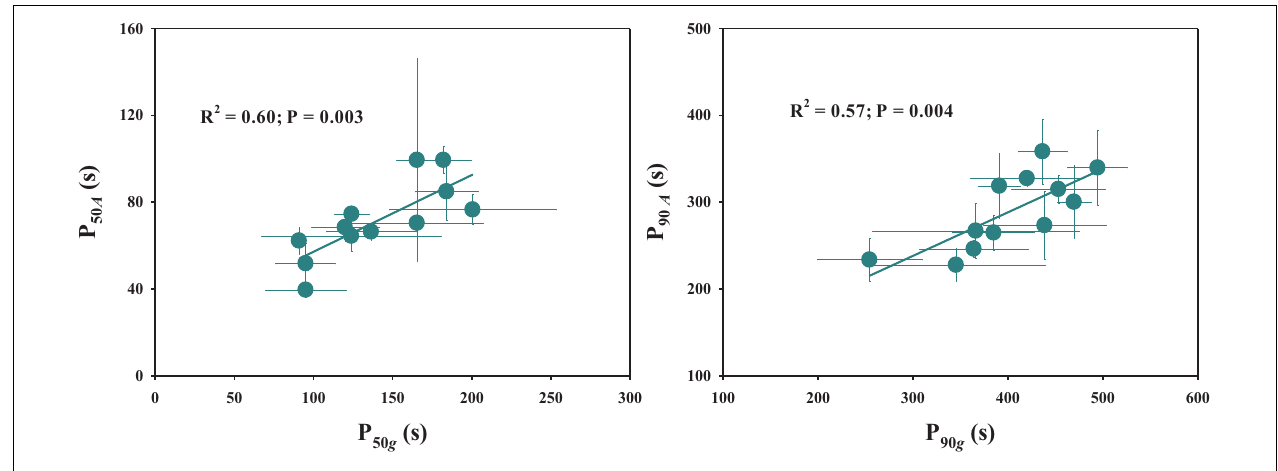
FIGURE 3 | Relationship between stomatal kinetics and photosynthetic induction. P 50 g and P 50 A represent the time taken for g s and A to reach 50% of the difference between the initial and final values, respectively. P 90 g and P 90 A represent the time taken for g s and A to reach 90% of the difference between the initial and final values, respectively. Points and error bars represent mean ± SD of three